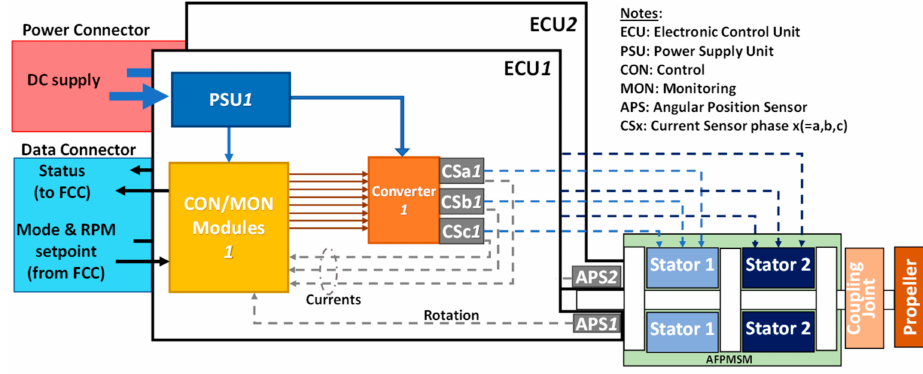
Figure 2. Schematics of the FEPS